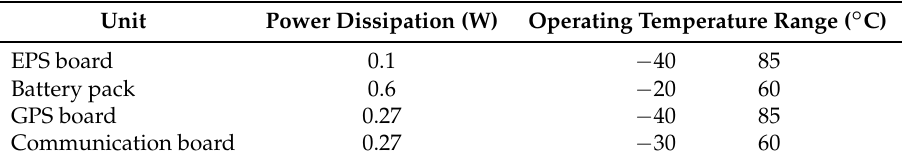
Table 1. Operating temperature limits for the main on-board systems [12].